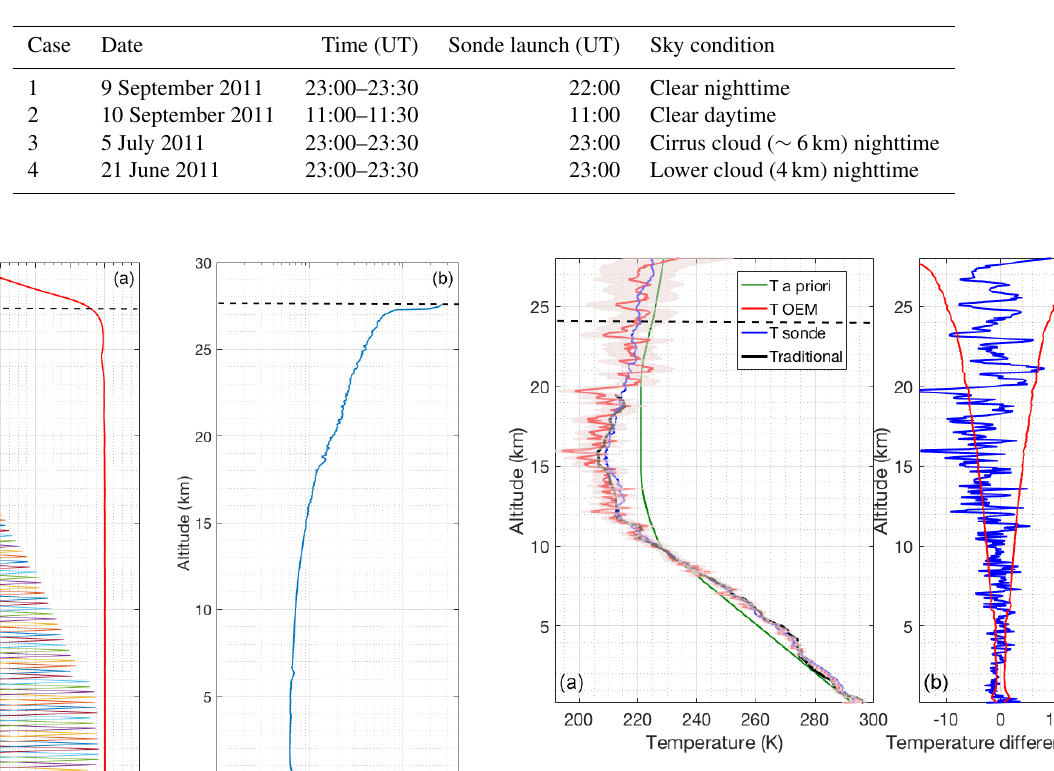
Table 3. Details of the four cases in clear and cloudy sky conditions we present to demonstrate the flexibility of our OEM temperature retrieval.